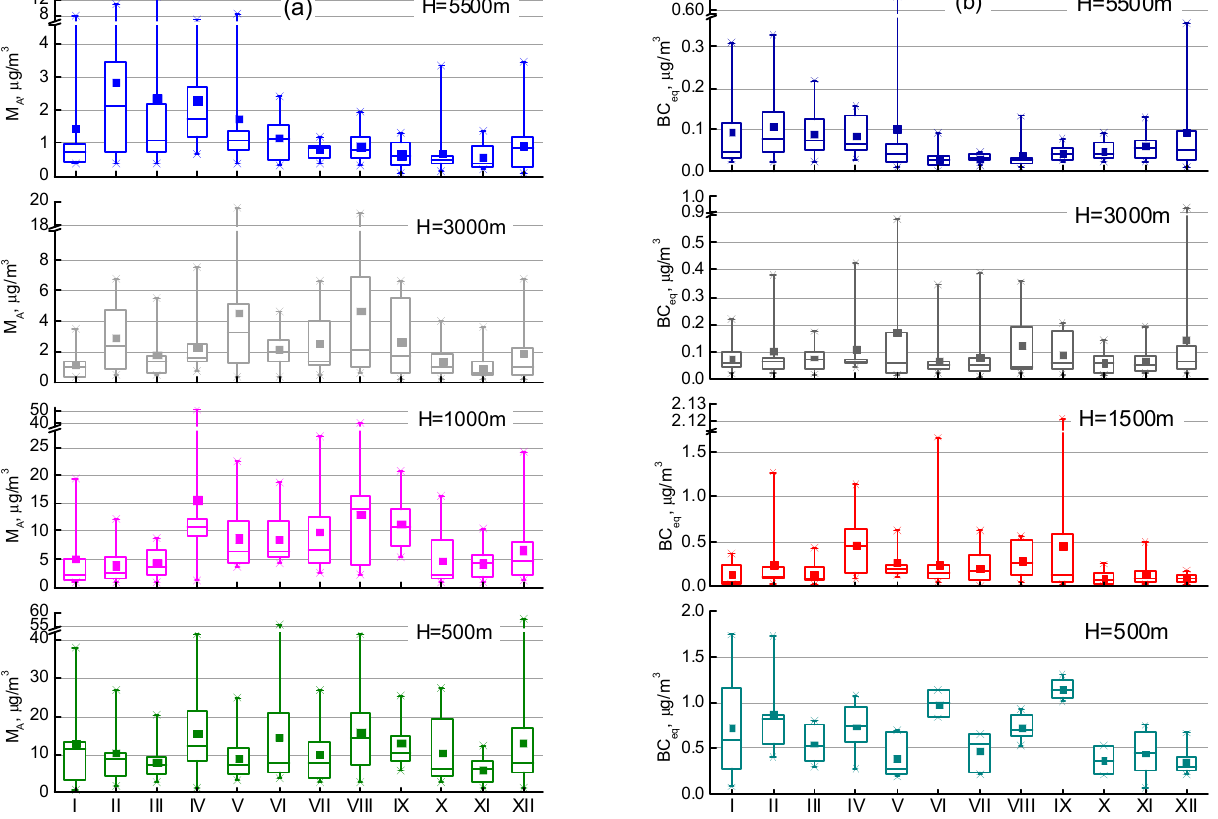
Figure 6. Seasonal behavior of the mass concentrations of ( a ) submicron aerosol and ( b ) BC eq at different altitudes taken from aircraft measurements in 2000–2018 (Zavyalovo village).